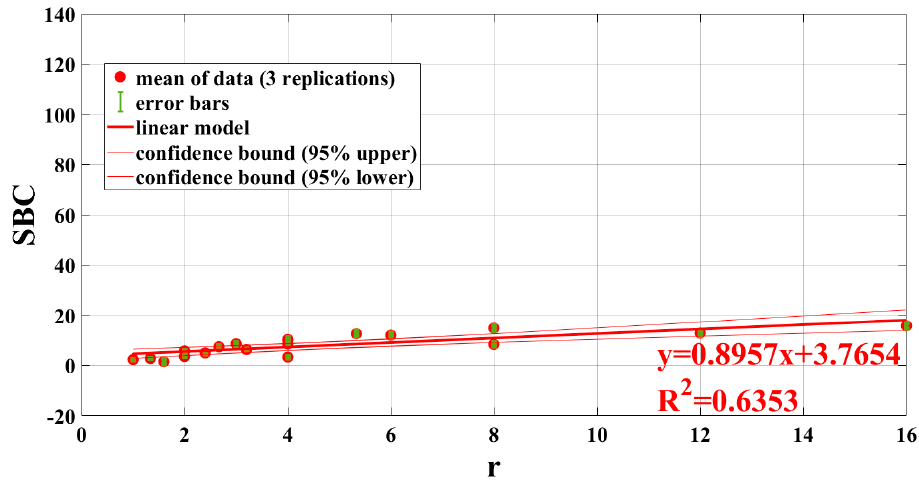
Figure 18. SBC versus r for R 2 512 frames, error bands and confidence bounds on the find linear model.